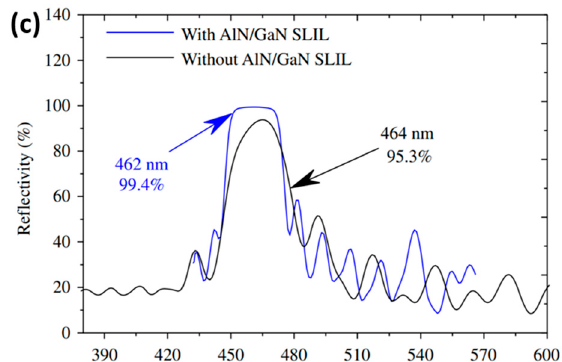
Figure 6. Transmission electron microscope (TEM) cross-sectional images of AlN / GaN DBR grown on sapphire substrate ( a ) with AlN / GaN SLIL, ( b ) without AlN / GaN SLIL, and ( c ) the corresponding reflectance spectrum. Copyright 2009 Journal of Crystal Growth [69].